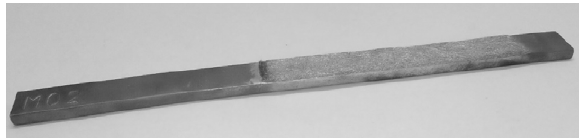
Figure 1. The fin with the fibrous layer